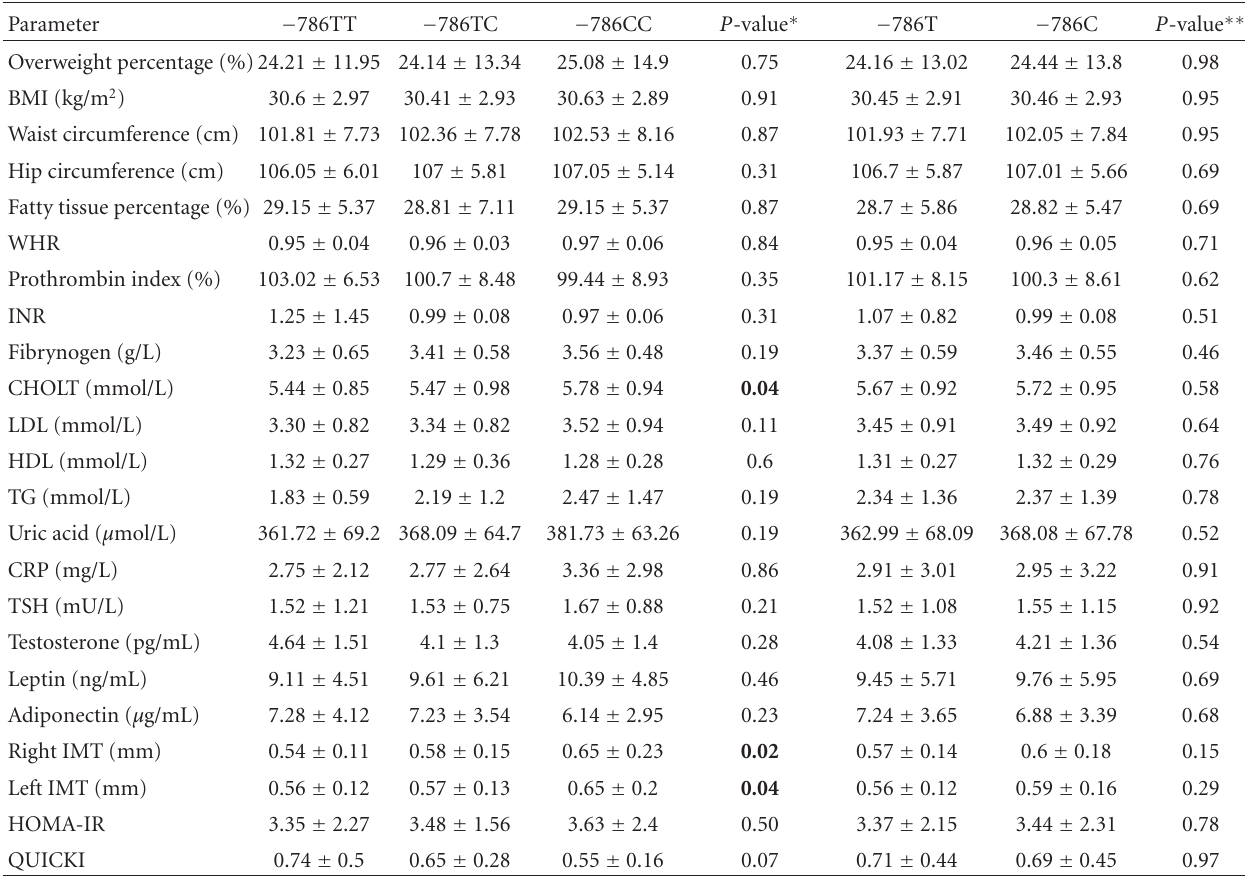
Table 3: The comparison of mean values of studied parameters in MS subjects.